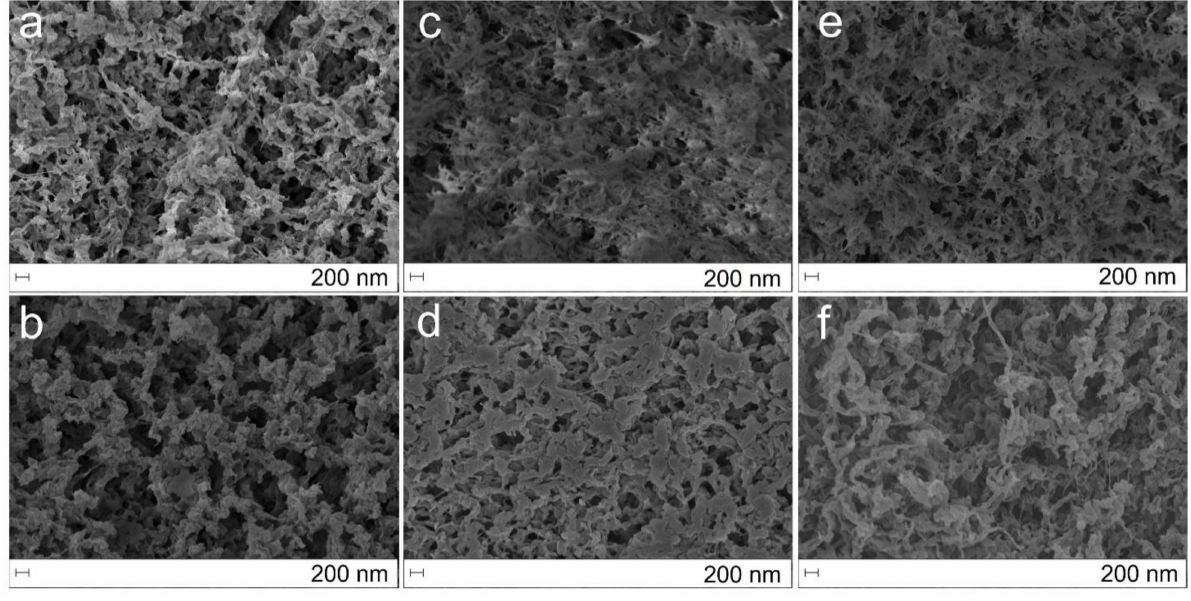
Figure 5. Textural appearance of the ( a , c , e ) interior of beads CHT:Glut 0.30% , CHT:Glut 0.30% :P[DADMA][OAc] 15% , CHT: P[DADMA][OAc] 15% , respectively, and ( b , d , f ) surface of beads CHT:Glut 0.30% , CHT:Glut 0.30% :P[DADMA][OAc] 15% , CHT: P[DADMA][OAc] 15% , respectively, by SEM imaging (scale bar: 200